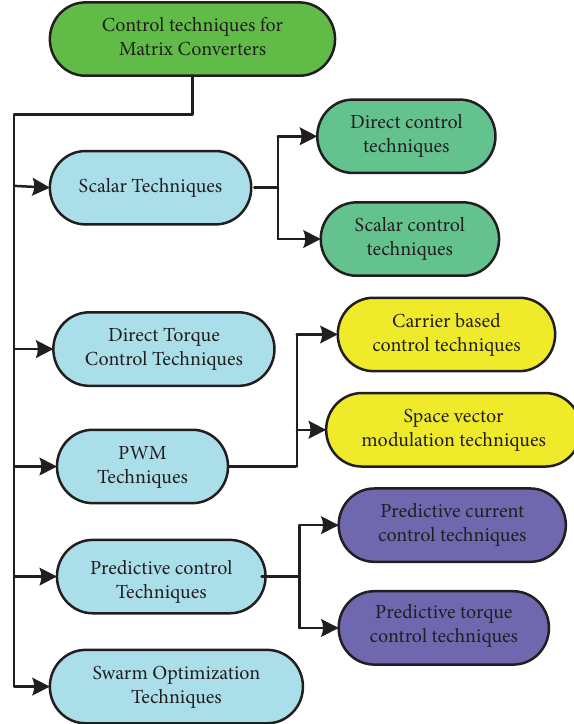
Figure 1: Various classifcations of controlling in